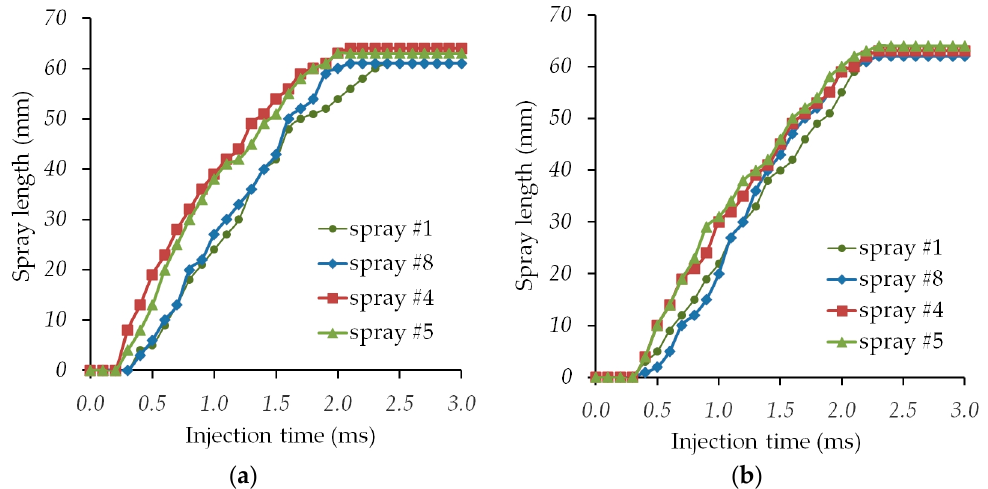
Figure 10. Dynamics of change in the length of the fuel sprays 1, 8 and 4, 5 for the nozzle 1 ( a ) and the nozzle 2 ( b ) with a rail pressure of 130 MPa.